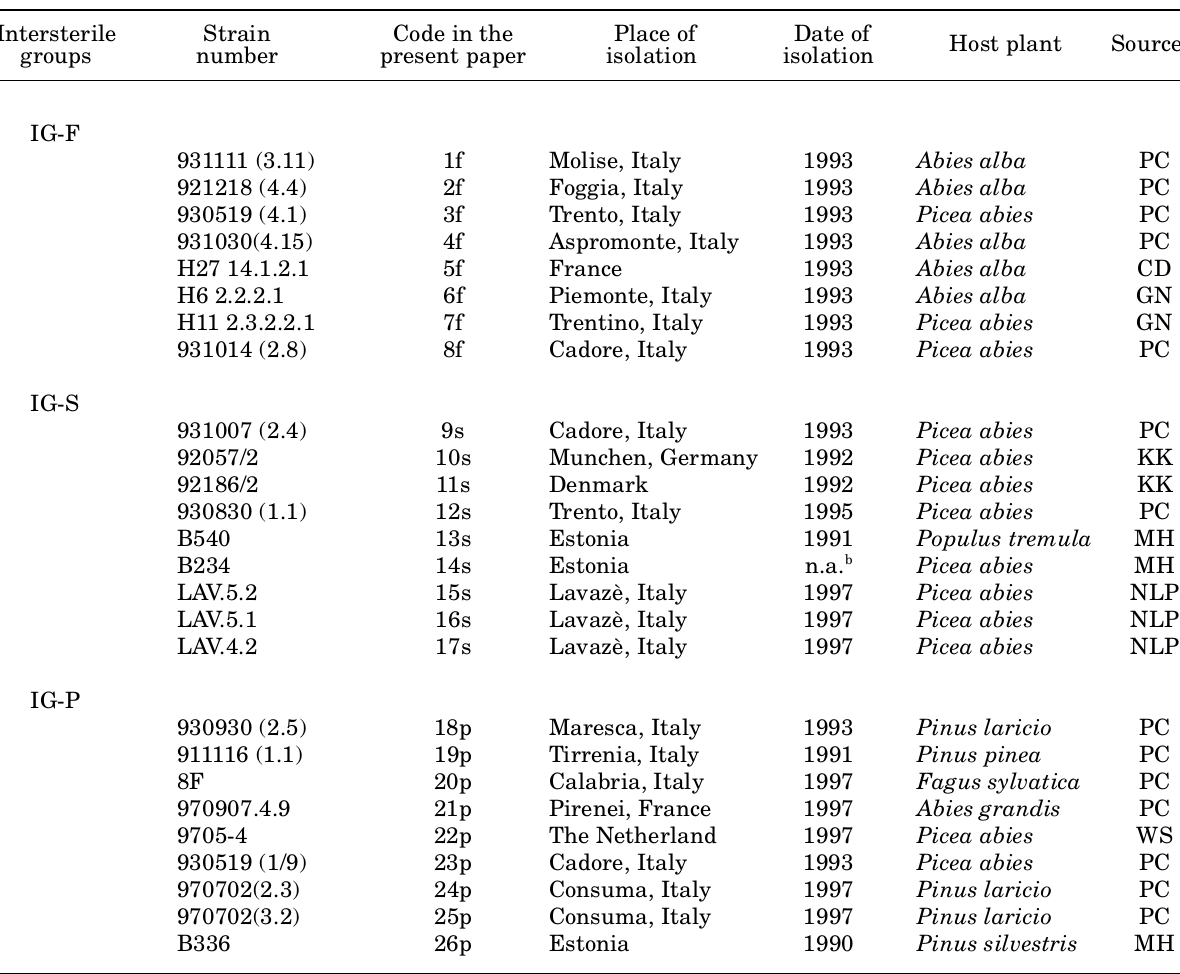
Table 1. Isolates of Heterobasidion annosum used in this study, separated into the intersterile groups (IGs) P, S and F. Intersterile Strain Code in